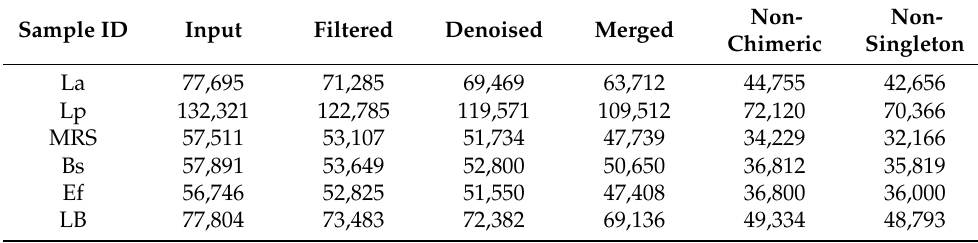
Table 3. Sample sequencing statistics.